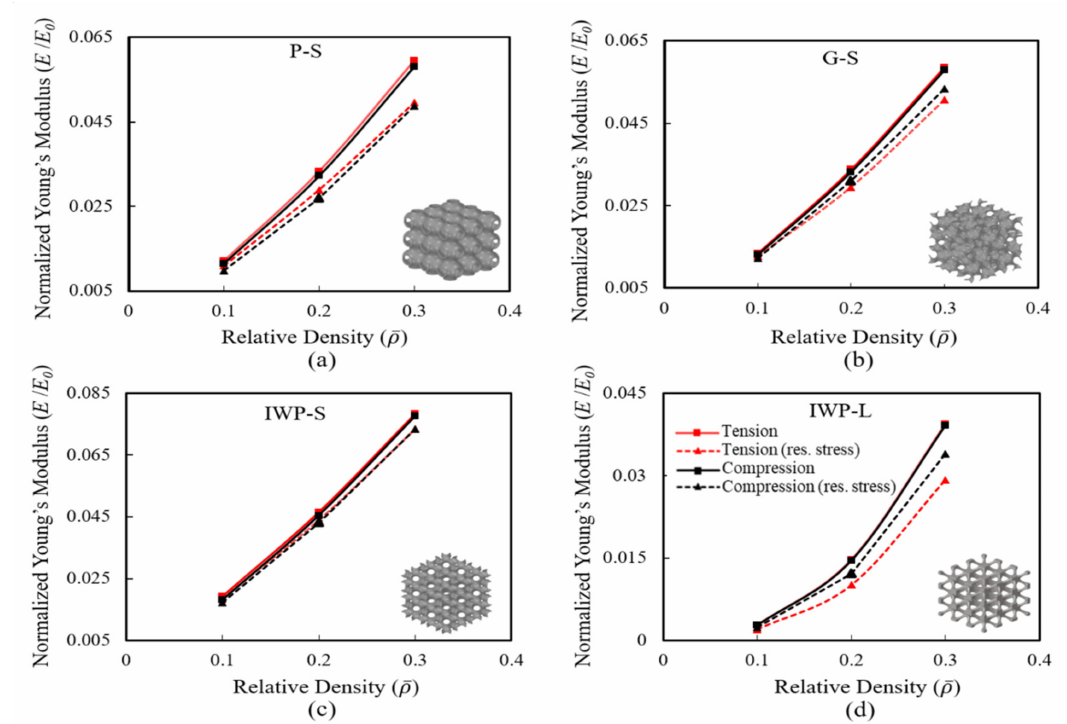
Figure 14. Effect of residual stresses on the normalized Young’s modulus ( E/E 0 ) with respect to